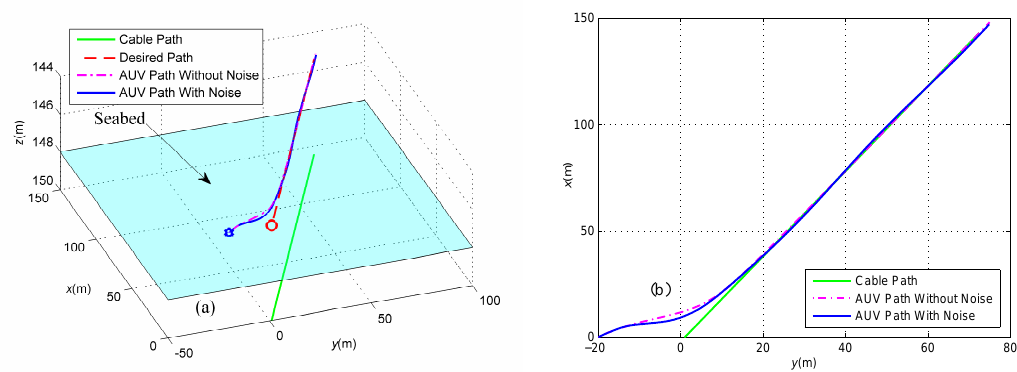
Figure 14. ( a ) Three-dimensional view of the cable tracking; and ( b ) Two-dimensional projection in the X - Y plane. These two pictures intuitively describe the cable tracking process, in which the green line represents the underwater cable, the red dashed line represents the desired tracking path, the magenta dot-dashed line represents the actual path of the under-actuated AUV without sensor noise and the blue line represents the actual path of the under-actuated AUV with sensor